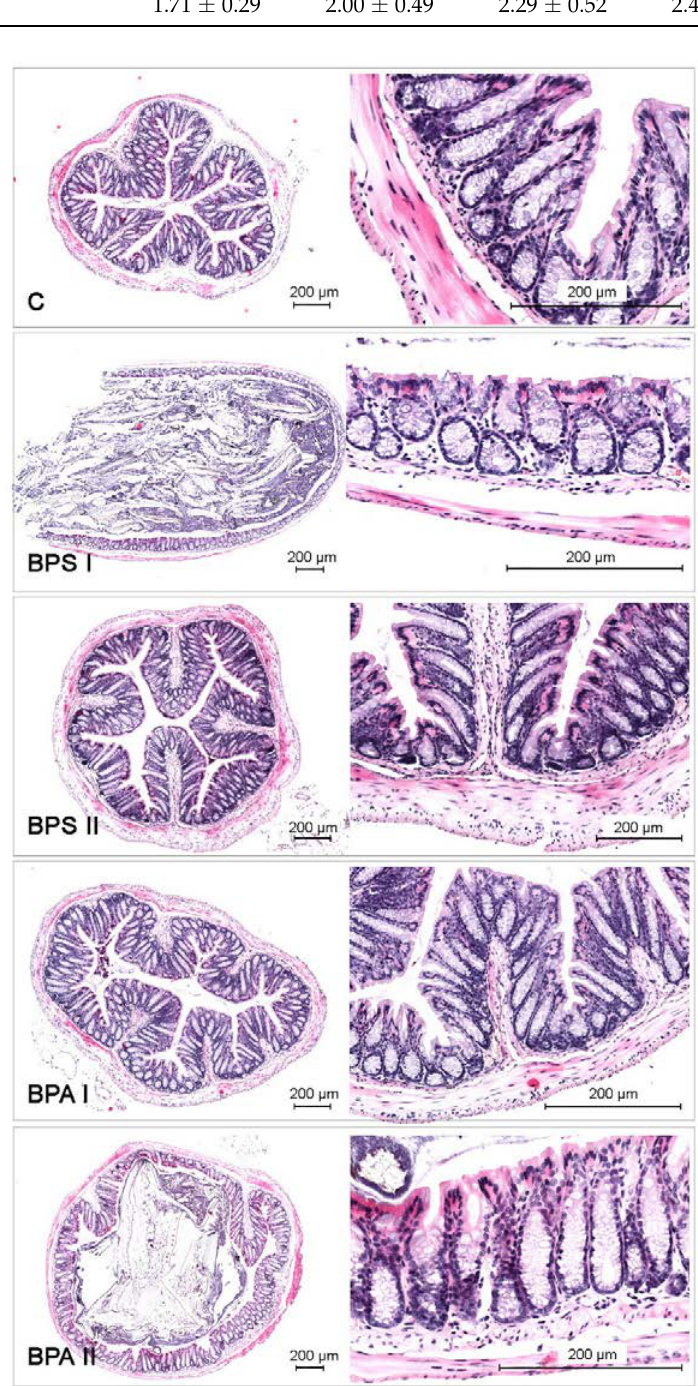
Figure 7. Histological staging of the colon collected from control animals (C) after administration of bisphenol S in low (BPSI) and high dose (BPSII) and after administration of bisphenol A in low (BPAI) and high dose (BPAII).